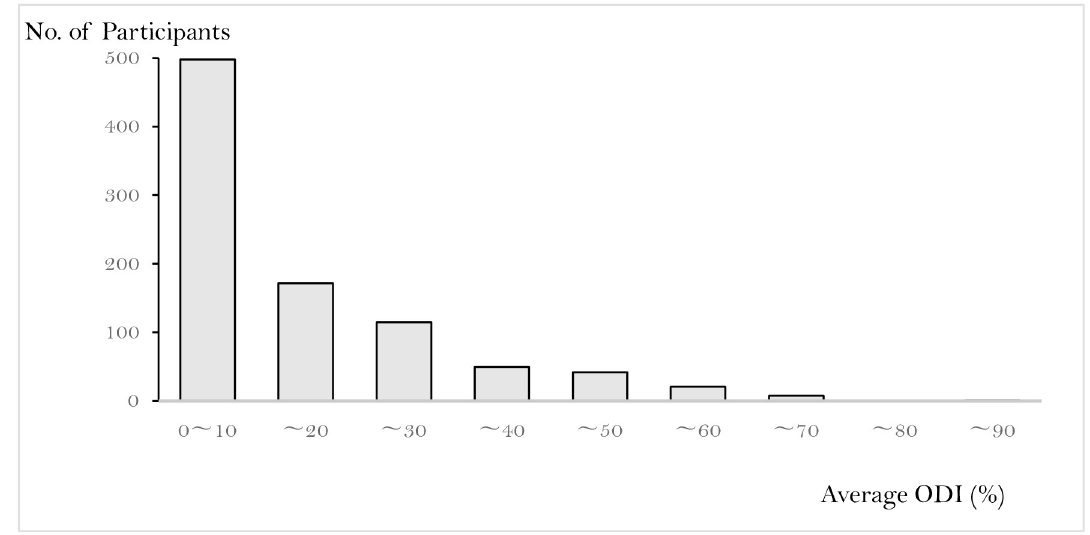
Fig 3. Distribution of ODI score. The participants’ average ODI is 12.8%.